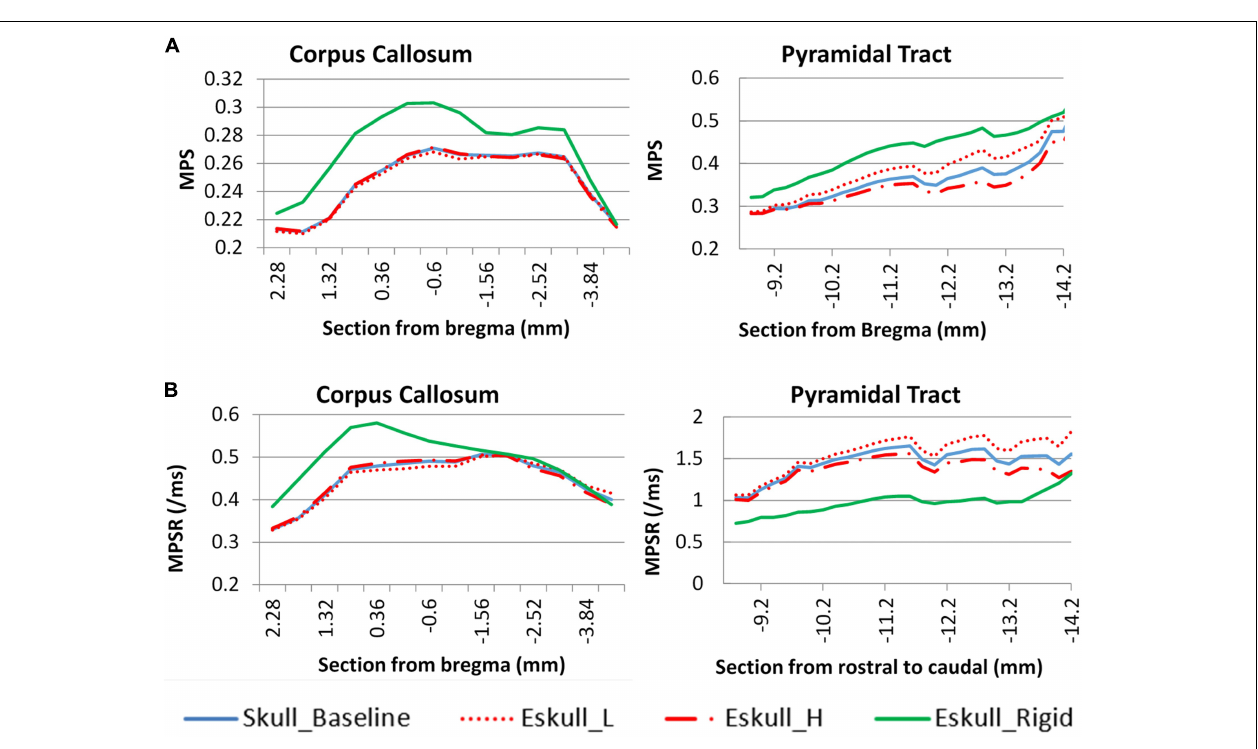
Frontiers in Bioengineering and Biotechnology |